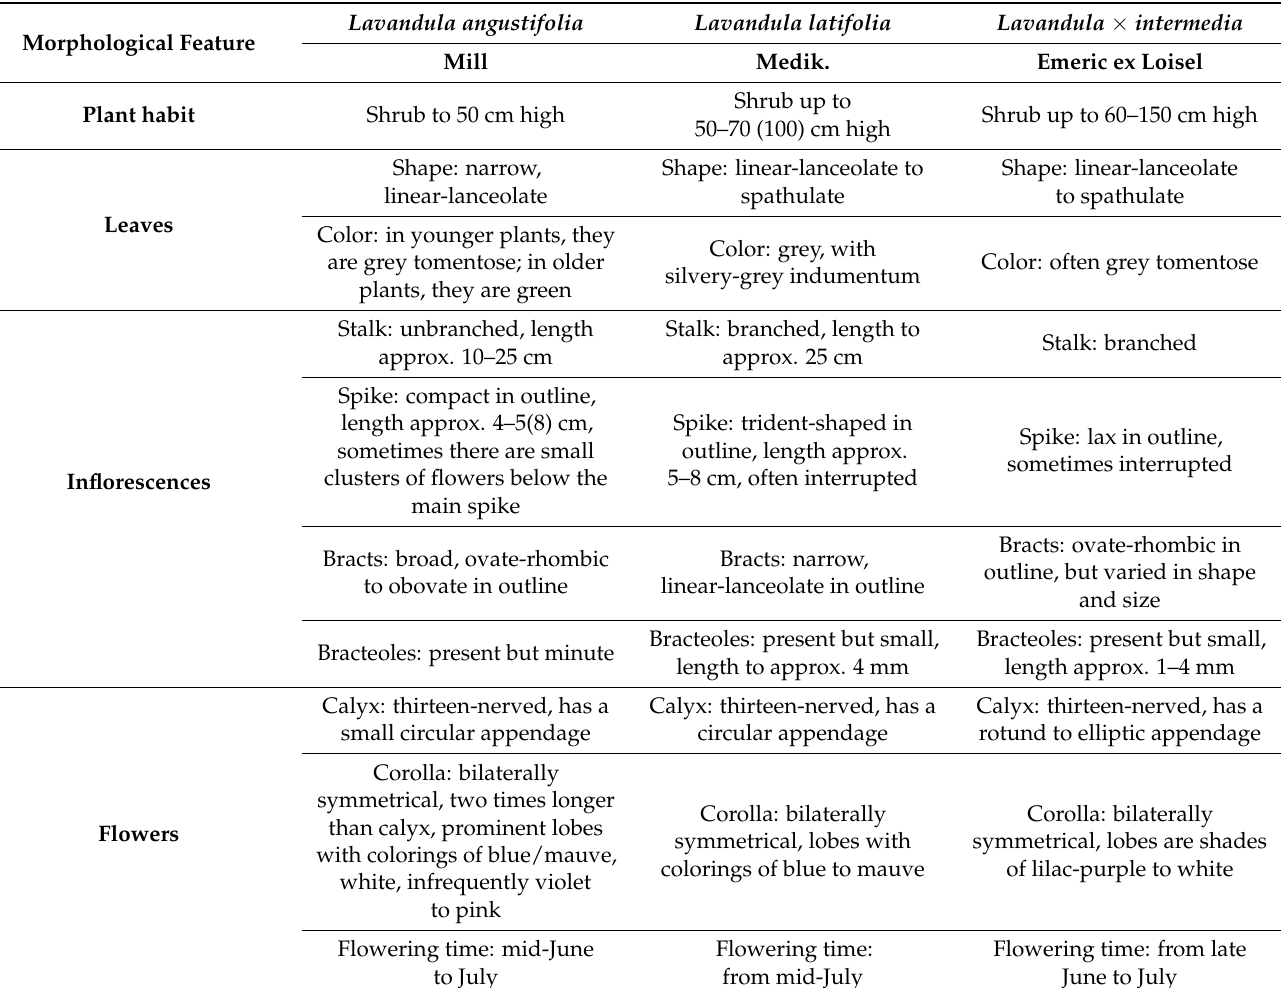
Table 2. Comparison of morphological features between Lavandula angustifolia , Lavandula latifolia , and Lavandula × intermedia